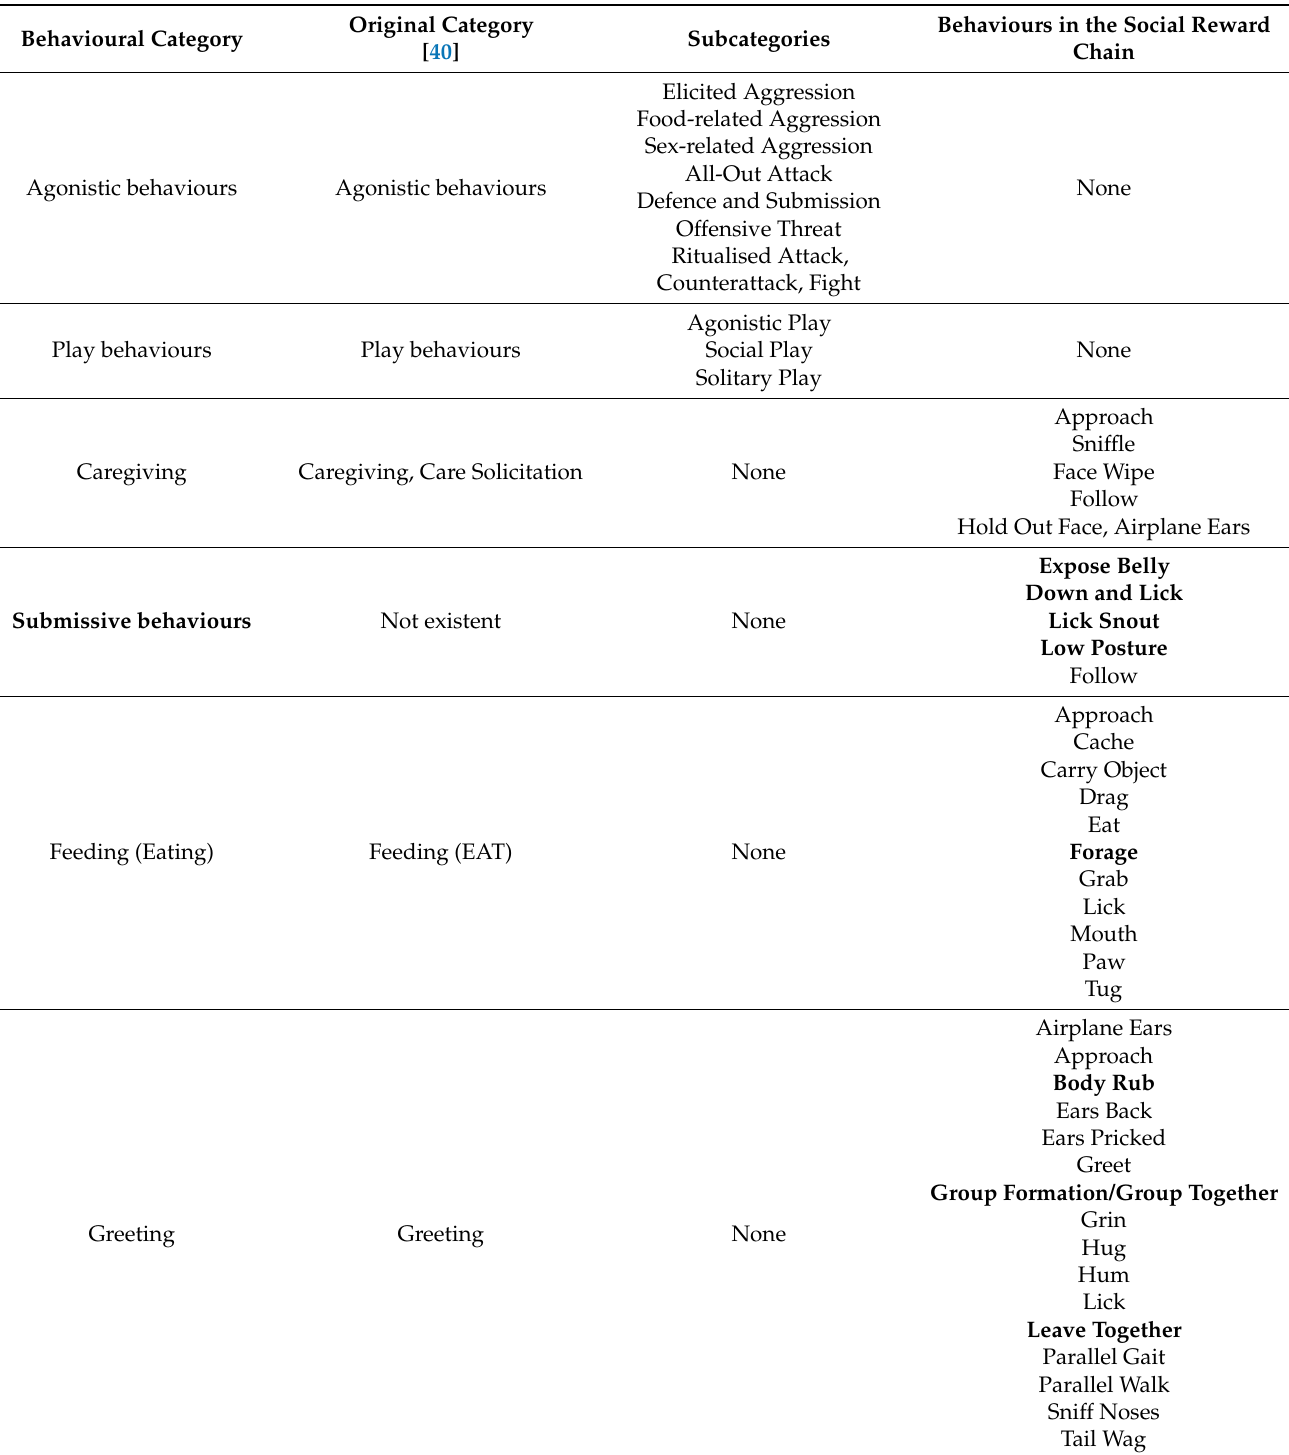
Table 2. Modified ethogram [40]. Behaviours and categories added to the ethogram are written in